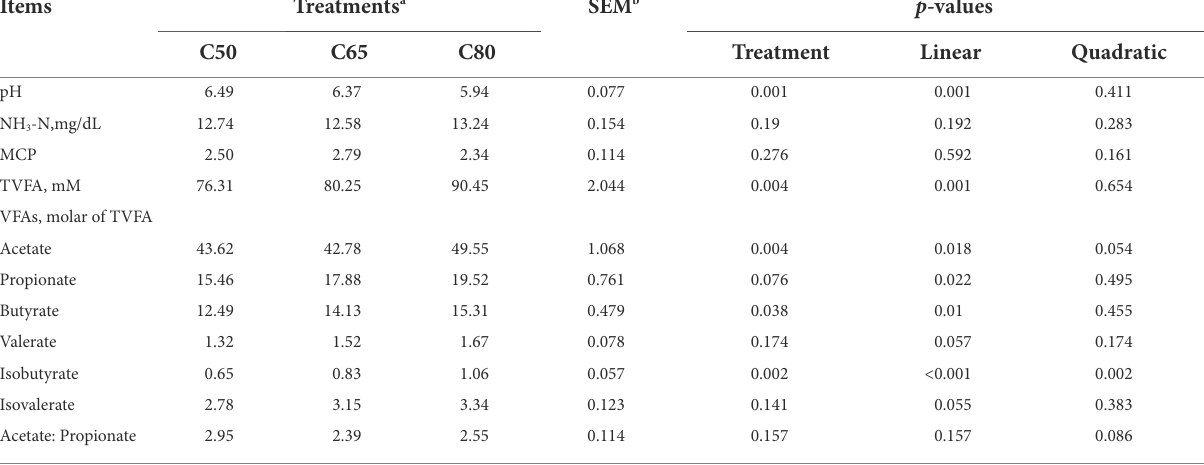
TABLE 2 Effect of dietary forage to concentrate ratios on rumen fermentation parameters.